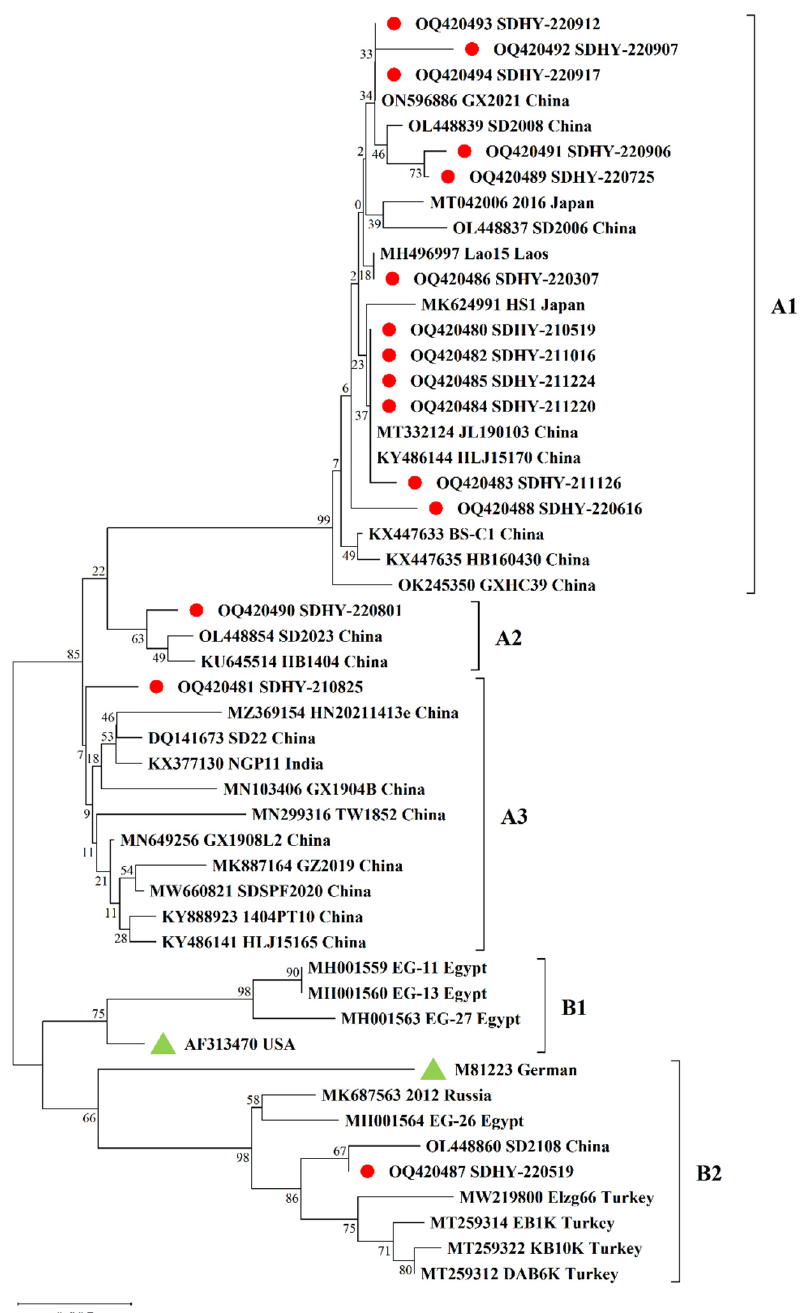
Figure 2. Phylogenetic tree of partial VP1 gene sequences of 15 isolates in this study and referred CAV strains. The phylogenetic analysis was carried out by the Neighbor-joining method by a bootstrap analysis of 1000 replicates using the MEGA X software program. The two major genotypes were identified as A and B. Genotype A was further differentiated into subtypes A1, A2, and A3, whereas genotype B was differentiated into subtypes B1 and B2. The 15 isolates were labeled with red circles, and the attenuated vaccine strain was labeled with a green triangle. A total of 35 reference strains were downloaded from Genbank, isolated from China and other countries.